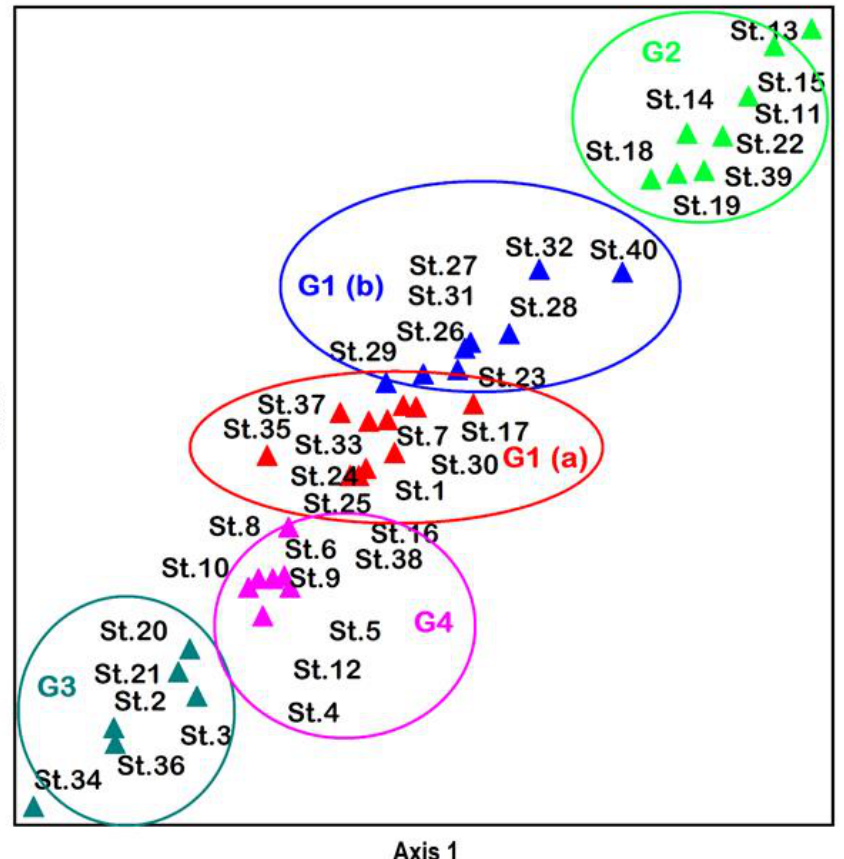
Figure 5. NMS stand ordination of the understory species, based on the frequency from the Shangla district, Pakistan. The four distinct groups (G1 – G4) and the subgroup (G1a) obtained from Ward’s cluster analysis of understory species were clearly imposed on ordination plan. (St indicates different stands in groups of vegetation.)